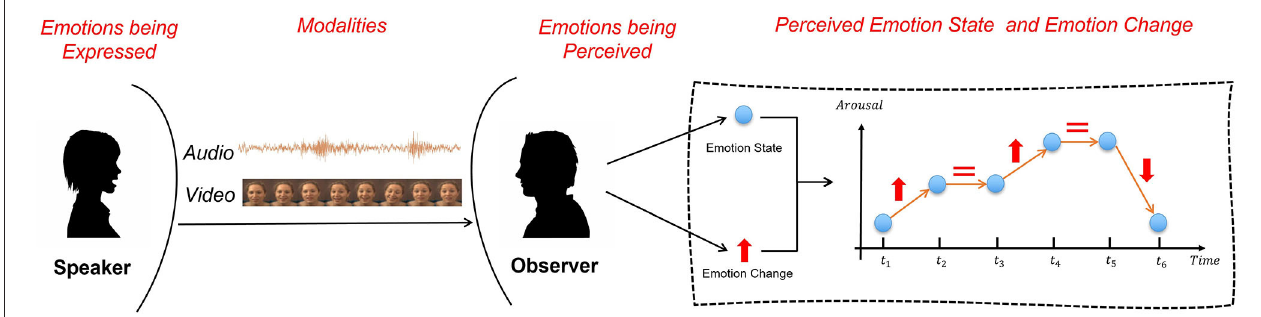
FIGURE 1 | The Brunswik’s functional lens model of the emotion expression and perception. The perception of two different aspects of emotion is depicted with the blue dots representing the absolute state at a point in time and the red arrow indicating the change in emotional state from one instance to the next (red equal sign indicates no change in